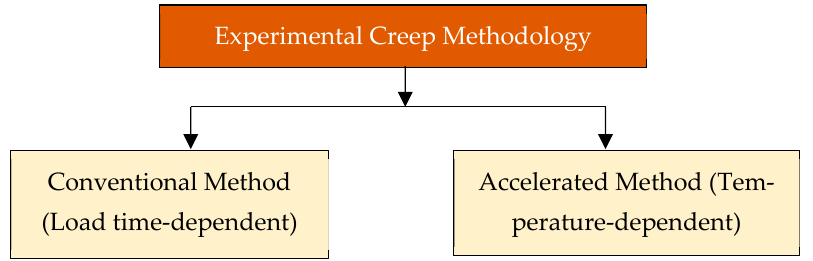
Figure 2. Overview of creep testing methods.